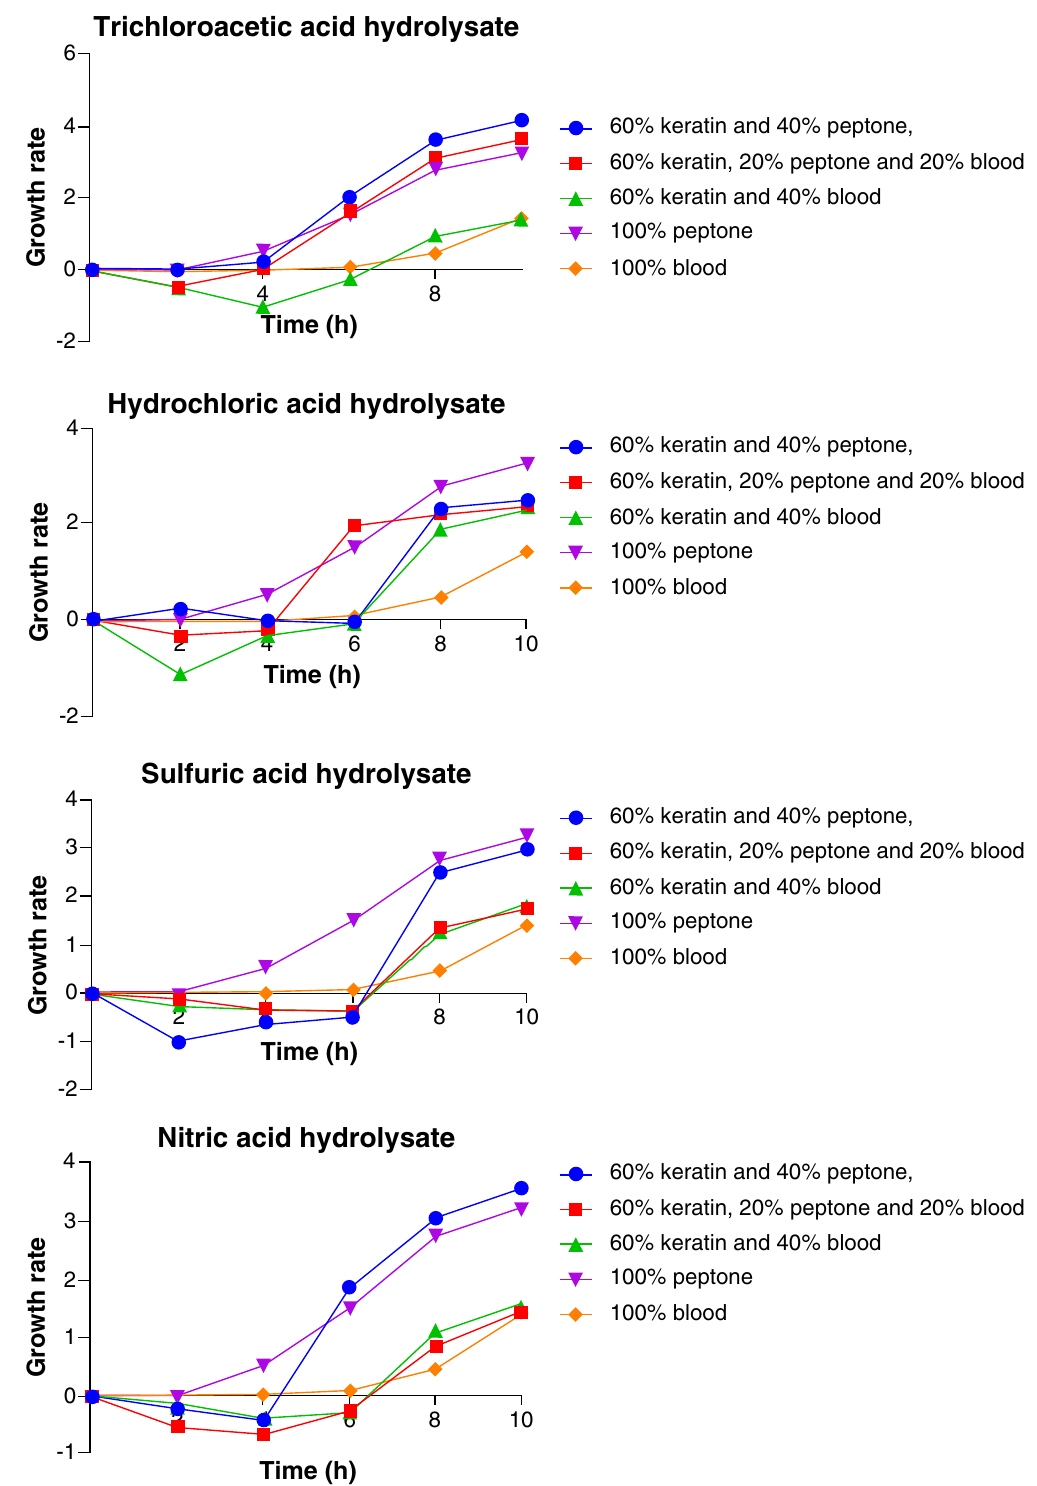
Figure 3. Growth rate of E. coli in media with the TCA, HCl, H